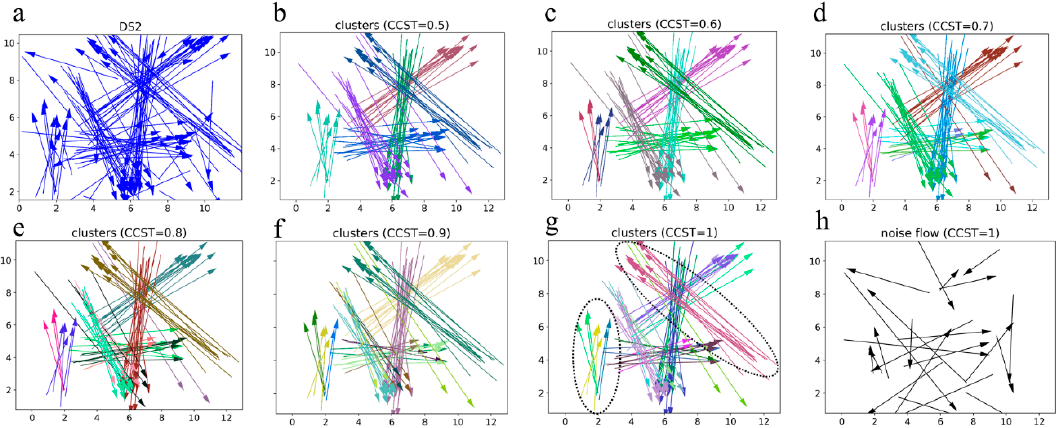
Figure 6. Clusters discovered by TOCOFC under di ff erent values of the Child tree / Child graph Self-Similarity Tolerance ( CCST ): ( a ) Raw data se tDS2; ( b – g ) Di ff erent clustering results when the parameter CCST is equal to 0.5, 0.6, 0.7, 0.8, 0.9, 1.0; ( h ) Noise flow detected by TOCOFC when the parameter CCST is equal to 1.